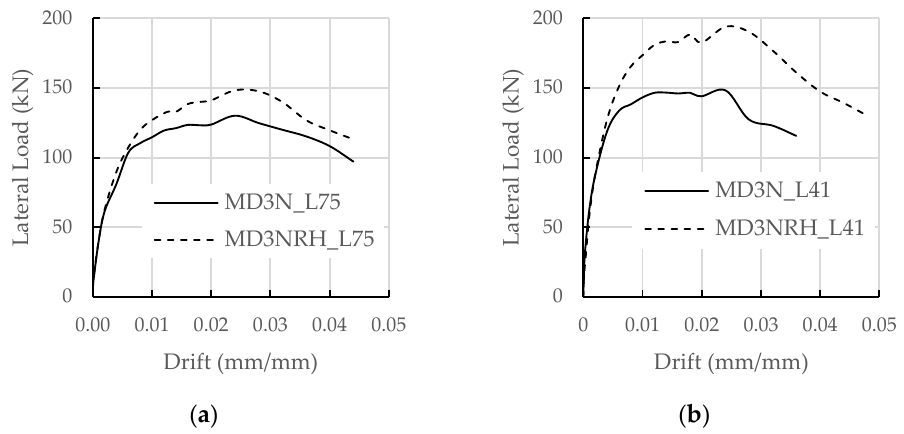
Figure 14. Envelope curves comparison. ( a ) Specimens with H/L = 0.75, ( b ) specimens with H/L = 0.41.